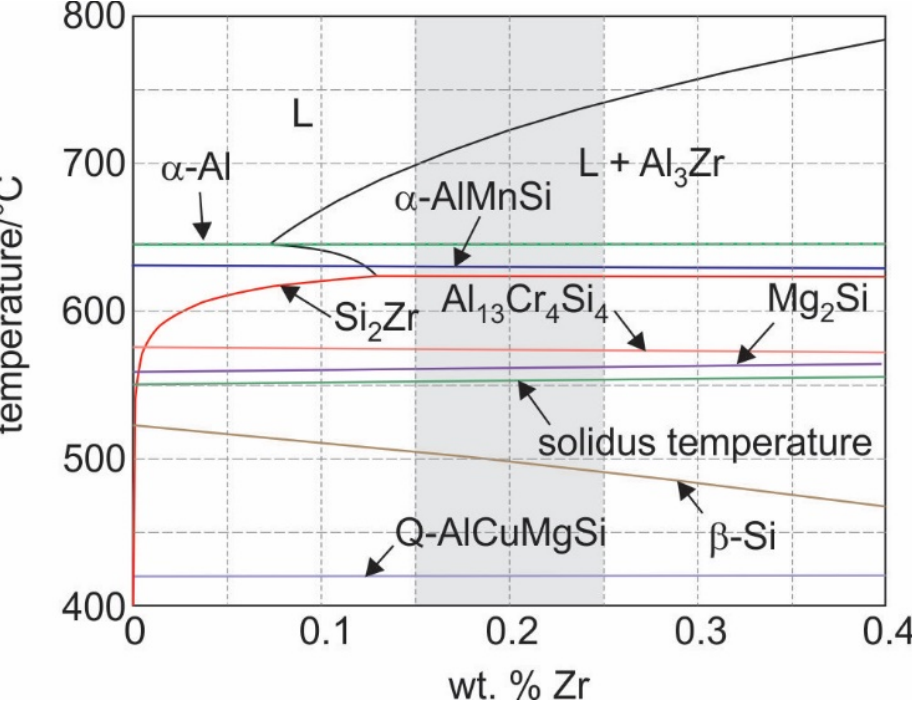
Figure 1. The effect of Zr on the liquidus temperature and formation of phases in the Al-corner. The shaded area indicates the content range of Zr in AA 6086, the contents of other elements are the same as in Table 2.